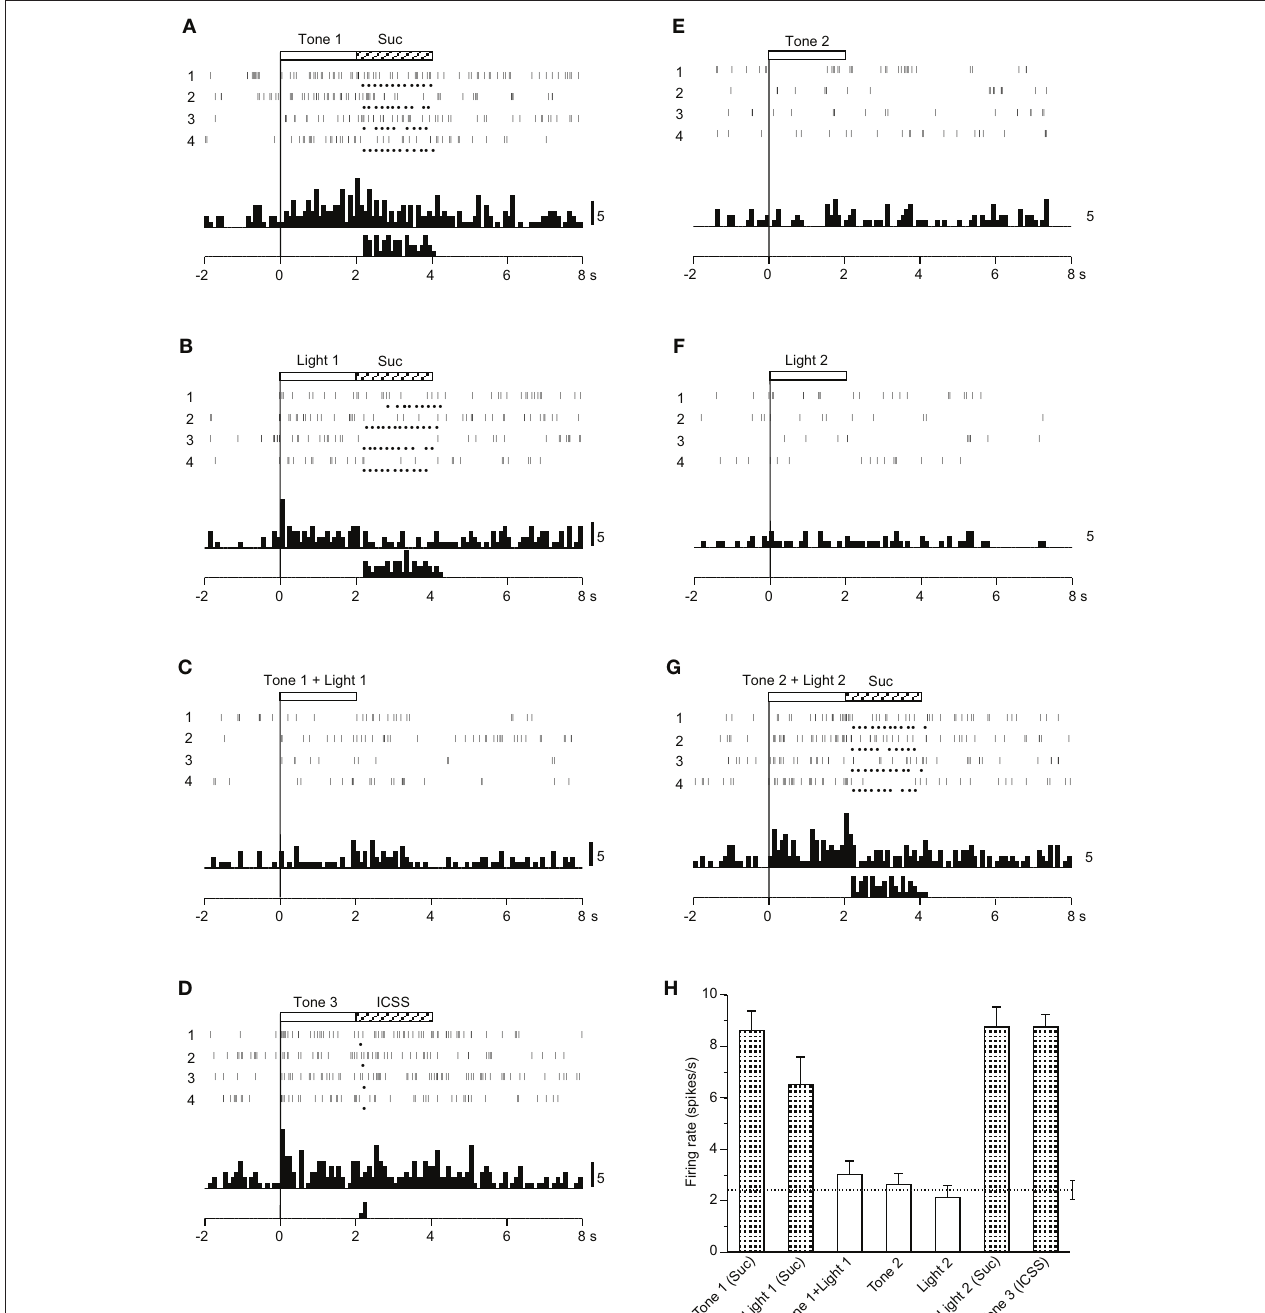
dot below the raster line indicates one lick; each upper histogram shows accumulated neuronal responses; and each lower histogram shows accumulated licks. Time scale, seconds; onset of conditioned stimulus at time 0; minus is a pre-trial control. Each histogram bin, 100 ms. Suc, 0.3 M sucrose solution. (H) Histogram of neuronal responses during presentation of each CS (mean firing rate ± SEM). A broken line with error bars indicates the mean spontaneous firing rate and the SEM during the pre-trial control phase. Shaded column, significant difference between the activity during presentation of a given CS and the spontaneous firing rate (new multiple range test after one-way ANOVA, p